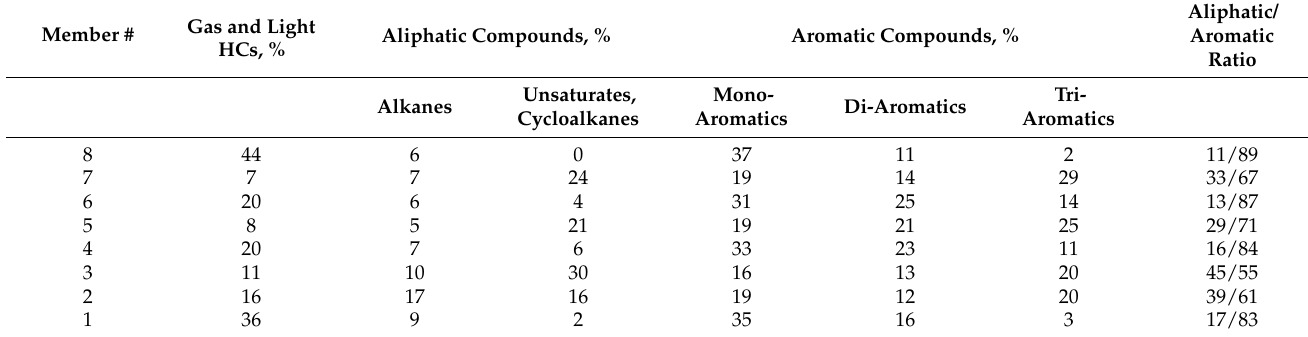
Table 3. Kerogen cracking products distribution obtained at 500 ◦ C and 0.5 min exposure time, calculated in % of total FID response. Member # Gas and Light Aliphatic Compounds, % Aromatic Compounds, % HCs, %